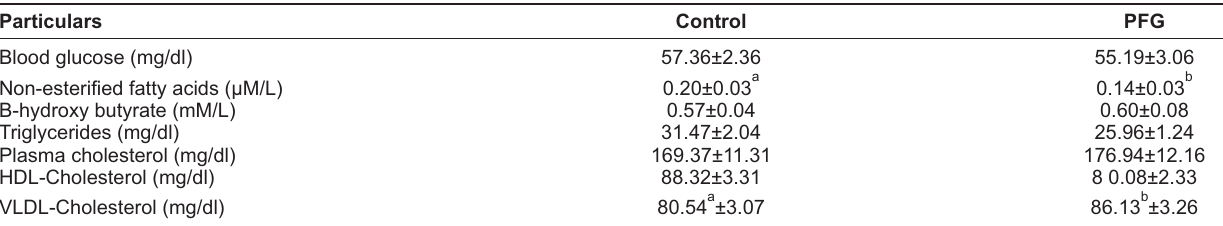
Table-4: Mean( plasma concentrations of plasma parameters in control and prill fat fed (PFG) cows during ±standard error) mid lactation